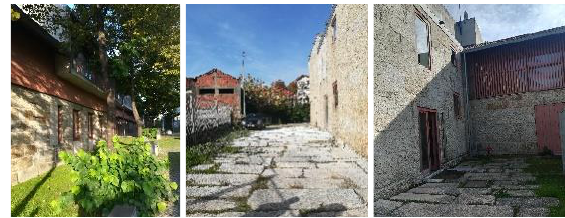
Figure 15. Series of images of the current state of the Multifunctional Couros Complex. Source: Author.